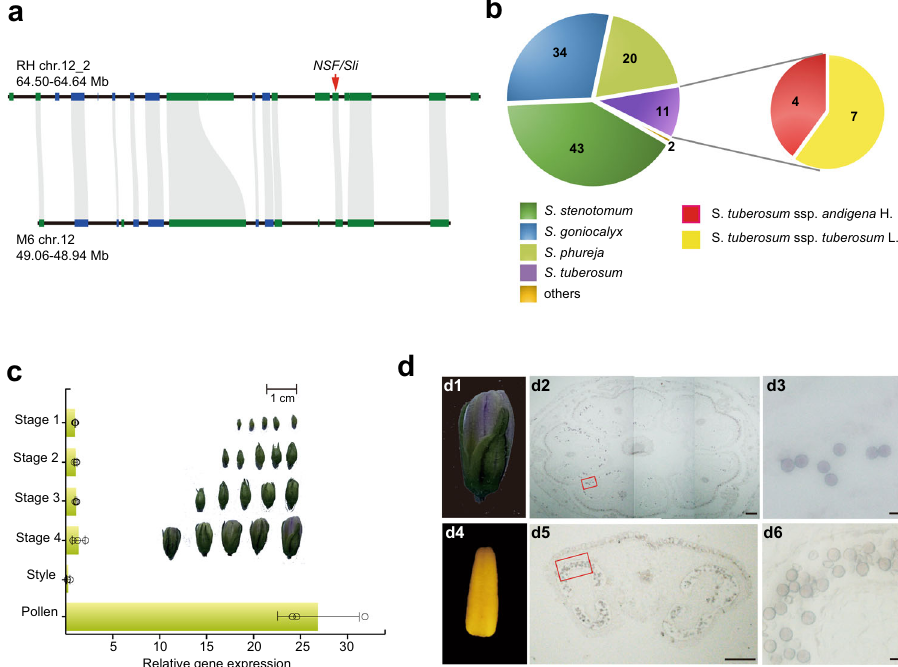
Fig. 2 Characteristics of NSF/Sli in rendering SC to self-incompatible diploid potatoes. a Collinearity analysis of the distal ends of chromosome 12 between RH and M6. Orthologous relations between the different syntenic loci are depicted by gray. The NSF gene is identi fi ed with the red arrow. b The number of self-compatible diploid potatoes induced by NSF/Sli . Six groups ( S. stenotomum , S. goniocalyx , S. tuberosom , S. phureja , S. ajanhuiri , and S. curtilobum ) and two subgroups ( tuberosum and andigena ) are indicated with different colors. The number represents the accessions that transfer from SI to SC after crossing with RH or E172. c Expression patterns of Sli in different developmental stages of RH fl owers. Development of the RH fl ower was divided into fi ve stages, including four developing stages according to bud size (status of each stage was shown as illustration) and one mature stage. Expression level was normalized to the expression in stage 1. StEF1- α was set as an endogenous reference gene. Data are presented as means ± s. d. ( n = 3 biological replicates). d In situ mRNA hybridization of Sli in the stage 4 fl ower bud and mature stamen. d1 and d4, the stage 4 fl ower bud (d1) and mature pollen (d4) used in the in situ hybridization assay. d2 and d5, the transverse sections of the stage 4 fl ower bud (d2) and mature stamen (d5). Bar 200 μ m. Magni fi cation of the red square in d2 and d5 are presented in d3 and d6, respectively (bar is 20 μ m). The experiments were repeated three times with similar